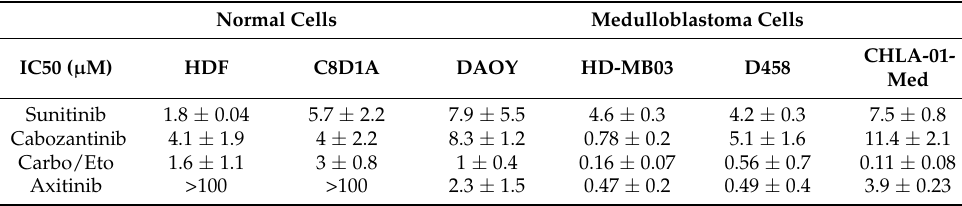
Table 1. Toxicity of antiangiogenic compounds and chemotherapeutic agents towards normal and MB cells. The IC50 ( µ M) values for various compounds determined by means of MTT tests after 48 h exposure of nontumor and MB cells (values are mean IC50 ± standard error of the mean from at least three independent experiments).